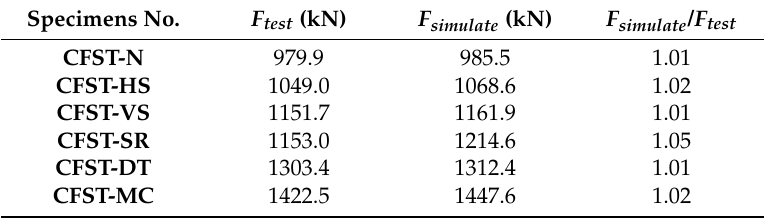
Table 8. Comparison between tested and simulated values of bearing